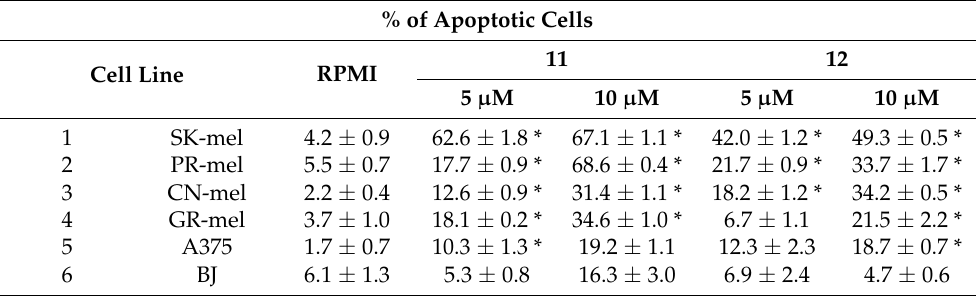
Table 3. Percentage of apoptosis—annexin V. Apoptosis induction was determined as the percentage of annexin V-positive cells. The table reports the percentages of apoptosis induced by 16-h treatments with 5 and 10 µ M of either 11 or 12 on malignant melanoma cells (1–5) and normal fibroblasts (6). Values in the table represent the mean percentage of annexin V-positive cells out of three independent experiments ± standard deviation. * p ≤ 0.01 (MM (1–5) vs. BJ (6)). % of Apoptotic Cells Cell Line